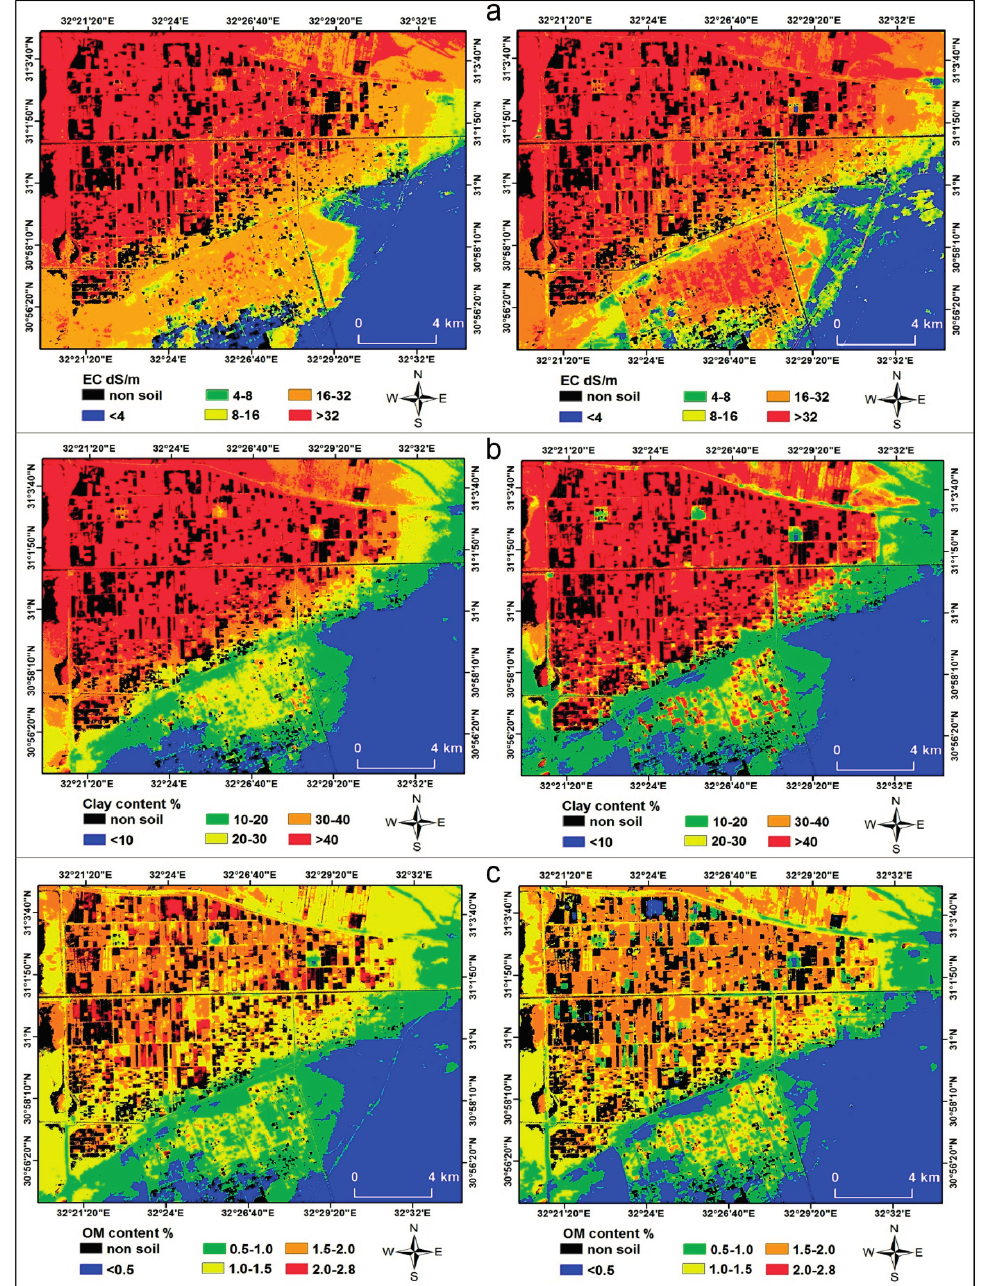
Figure 7. ( a ) Soil salinity (EC e ), ( b ) clay content and ( c ) OM maps based on the PLSR ( left ) and MARS ( right )